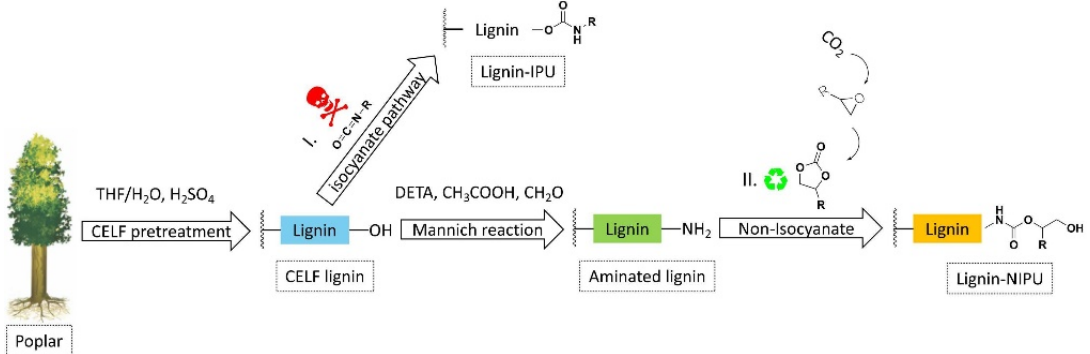
Figure 4. Synthesis procedures for polyurethanes obtained from lignin via ( I ) isocyanates pathway and ( II ) nonisocyanates way. Reprinted with permission from [23]. Copyright 2022, Elsevier Ltd.